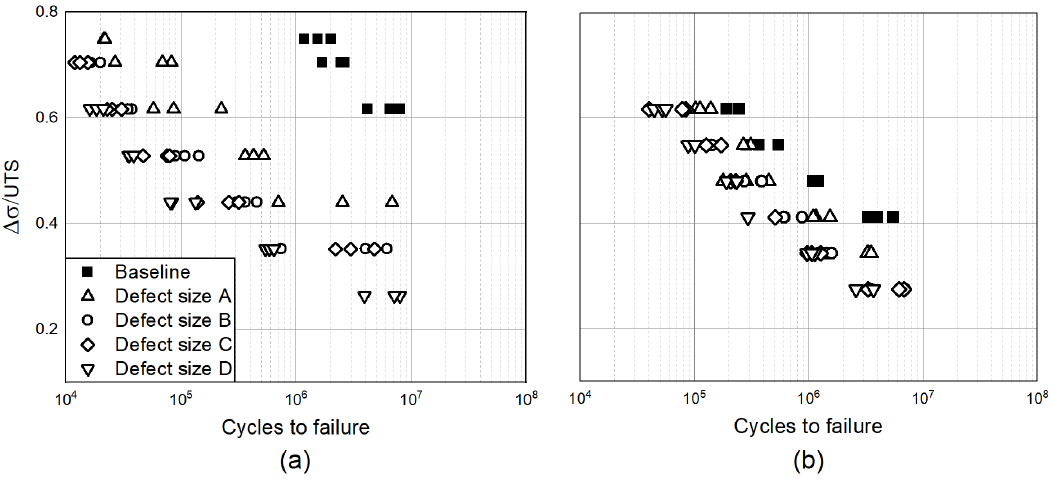
Figure 3. Experimental fatigue results of ( a ) Ti6Al4V and ( b ) Inconel 718: a comparison between different series of defect size at R = 0.1.